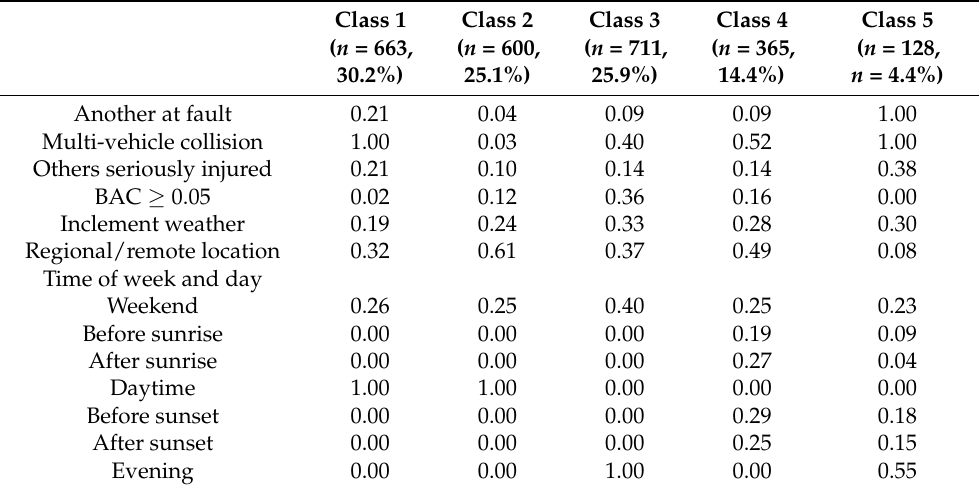
Table 2. Proportion of cases in each of the five classes who had the indicated